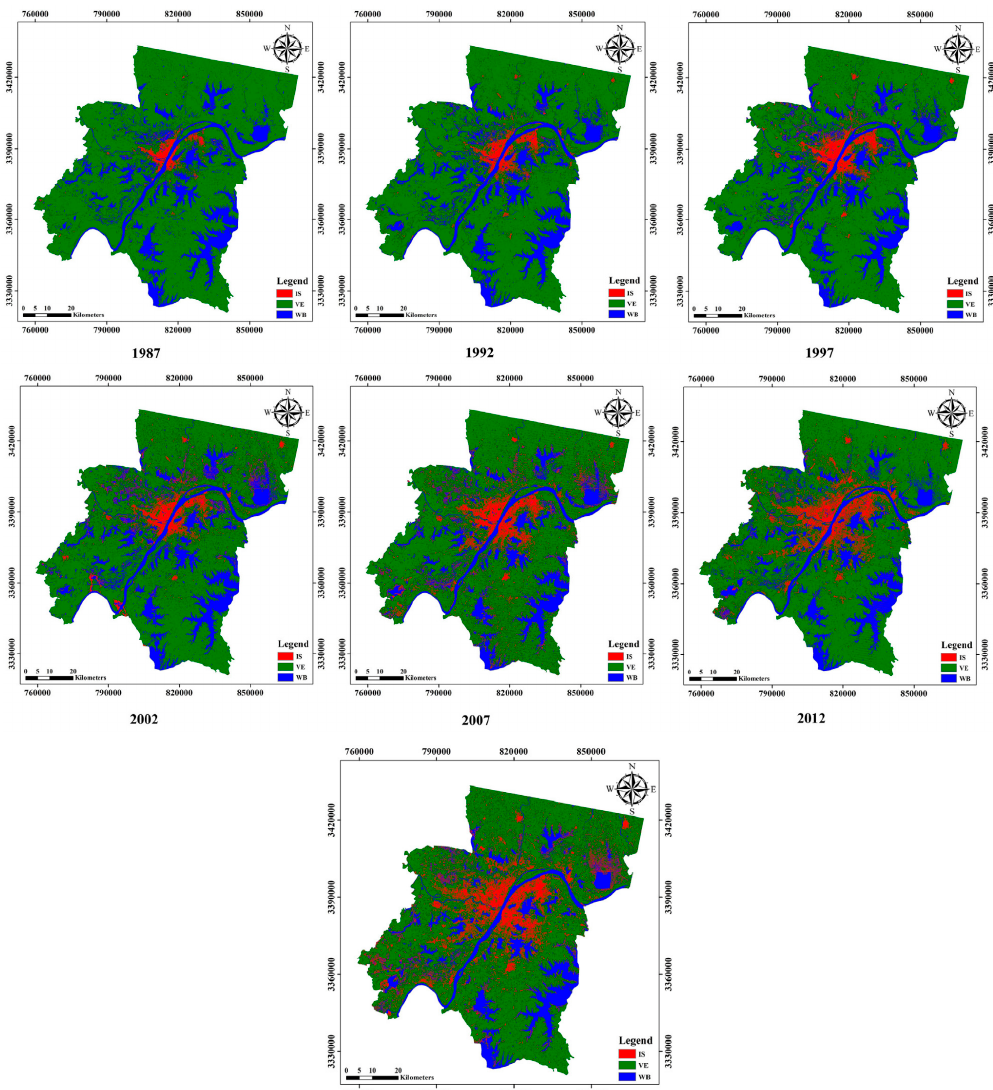
Figure 7. Impervious surfaces area maps of Wuhan City from 1987 to 2017 [96].